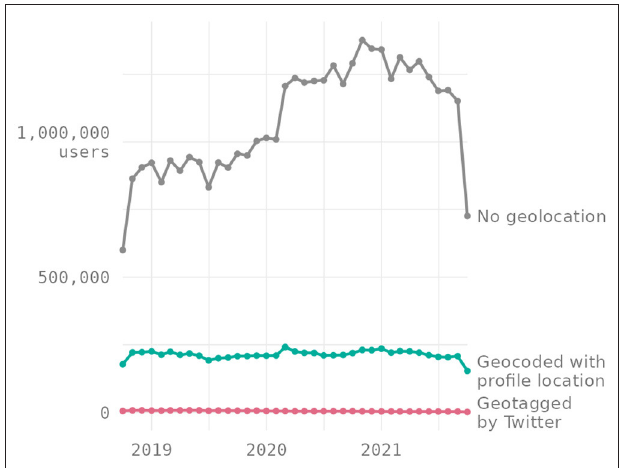
FIGURE 2 | Number of monthy active Twitter users in our